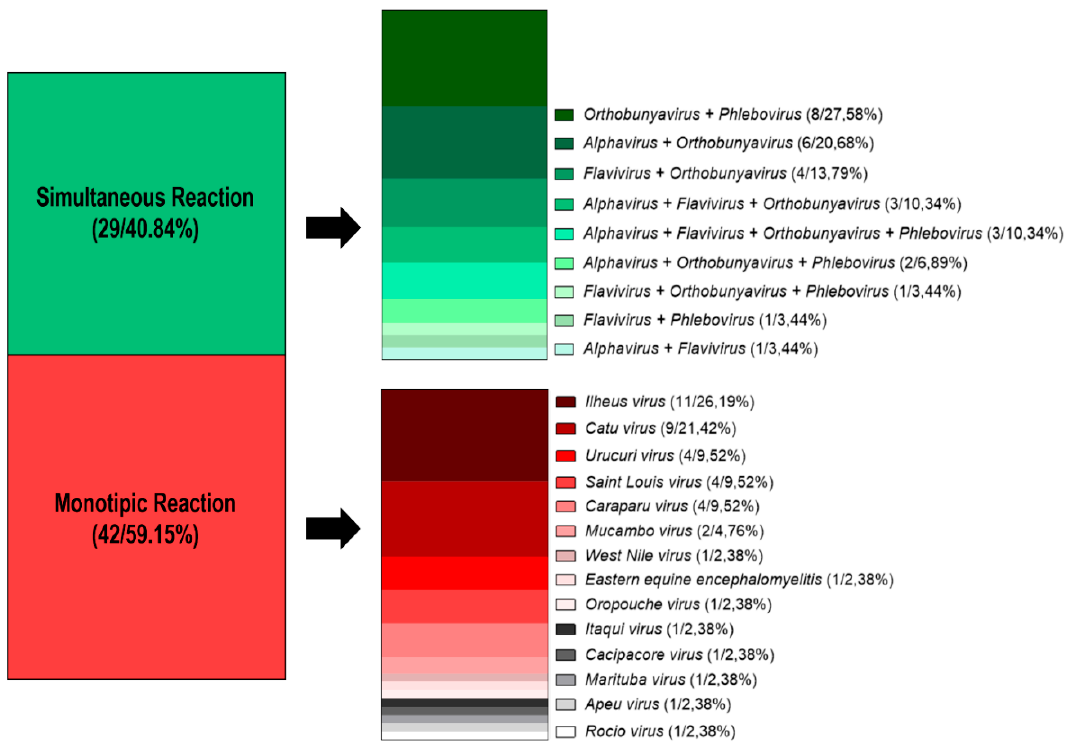
Figure 2. Quantitative and percentage of simultaneous and monotypic reactions detected in samples sera of wild vertebrates from FLONA of Caxiuanã between 2014 and 2016.